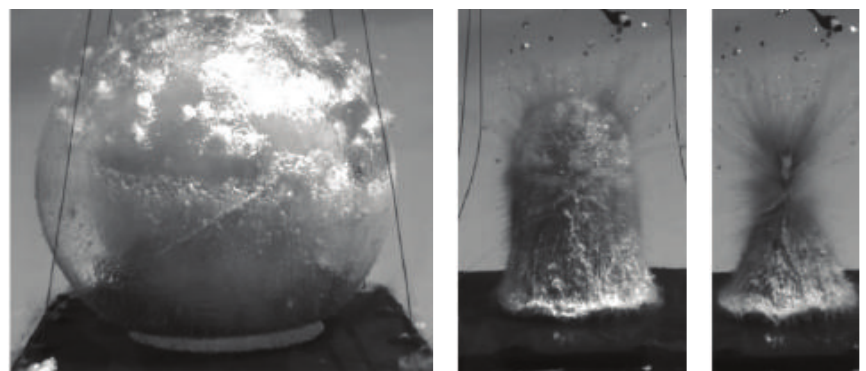
Figure 15: UNDEX bubble shape and water hammer [16].